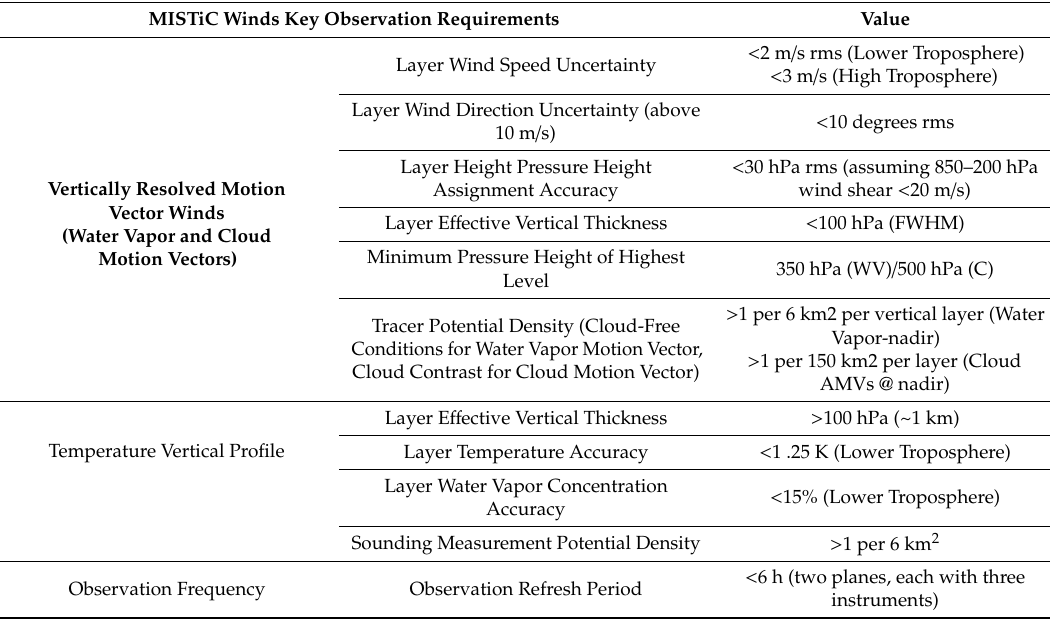
Table 2. Key vertically resolved wind and thermodynamic profile observation